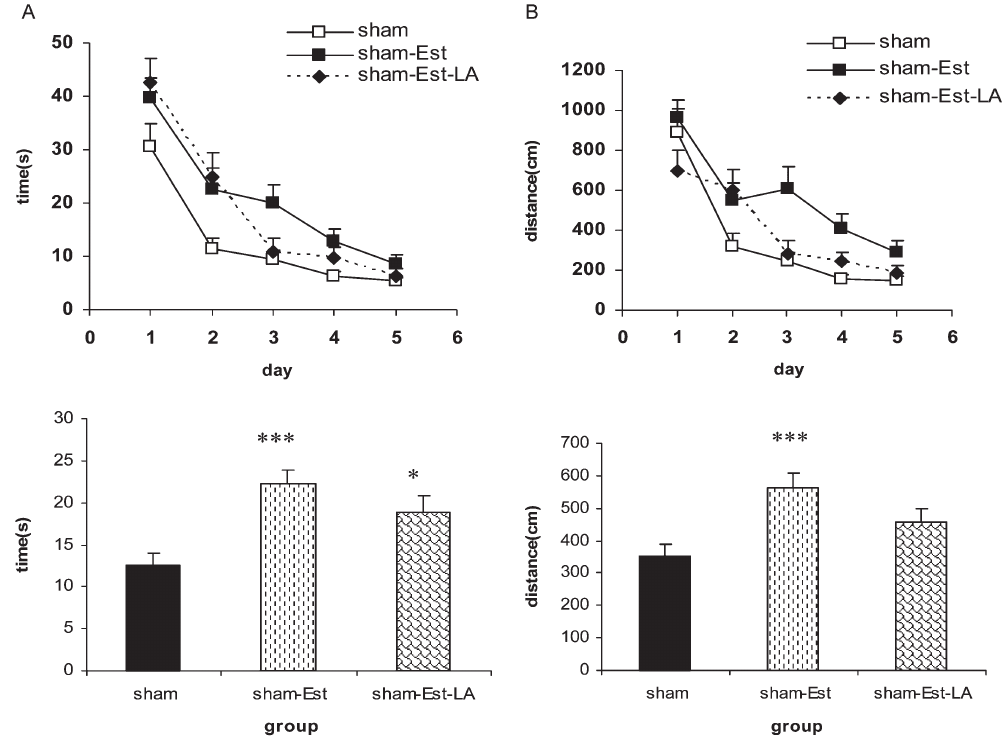
Figure3 -Comparisonoftimelatency(A)andpathlength(B)amongsham,sham-Estandsham-Est-LAgroups.Dataarepresentedasmean ¡ SEM. (n=8ineachgroup). *** P , 0.001compared toshamgroup.Theupper portion ofthefigurecompares groups’ total timelatency ortraveledpath length over five days, and the lower portion of each figure is the comparison of time latency or traveled path length each day between